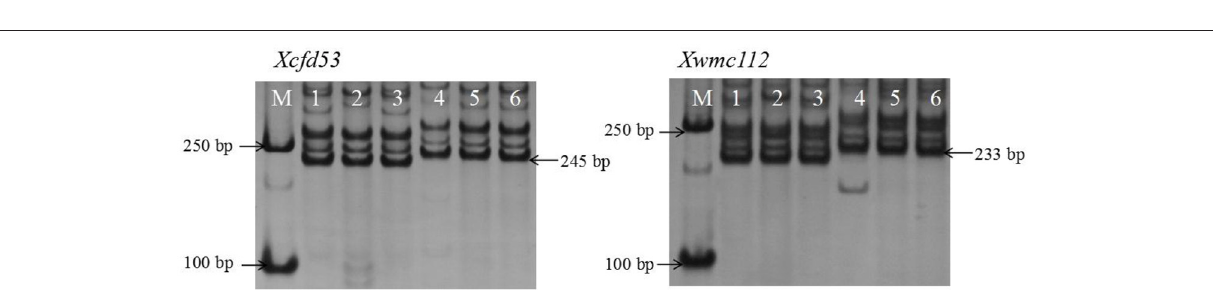
FIGURE 4 | The size of PCR fragments of Xcfd53 and Xwmc112 in six extreme individuals of the BC 3 F 2 population. M: DL2000; lanes 1, 2, and 3 represent short-spike materials; and lanes 4, 5, and 6 represent long-spike